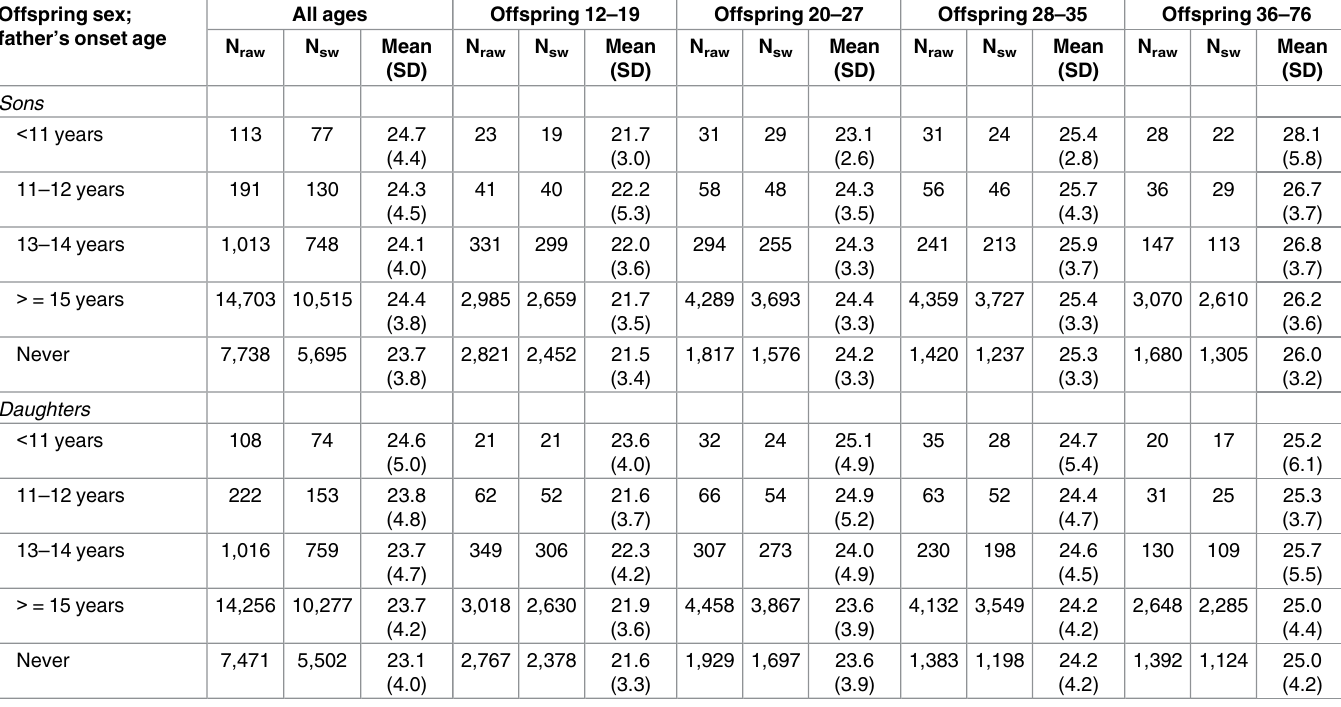
Table 2. Unadjusted mean (SD) offspring BMI at various ages, according to father’s age of smoking onset. Offspring sex; All ages father’s onset age